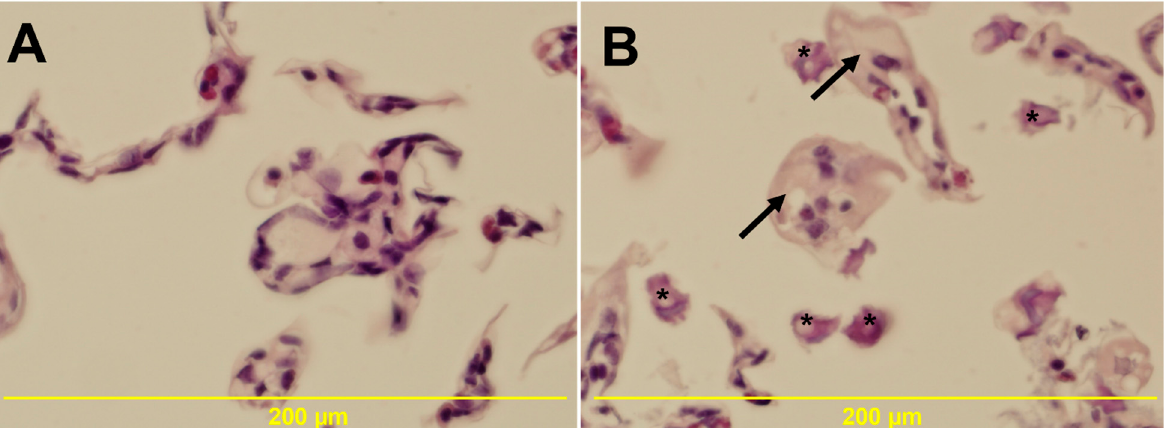
Figure 4. Transverse and longitudinal section of juvenile marbled crayfish Procambarus virginalis gill (N = 6; 200×). ( A ) gill of control crayfish; ( B ) gill of crayfish exposed to AE, 4.0 µg/L + AMPA, 4.0 µg/L for 50 days, with the most pronounced changes represented by swelling of gill epithelium (arrows) and unidentified fragments in interlamellar space (asterisk)—histopathological score 2.